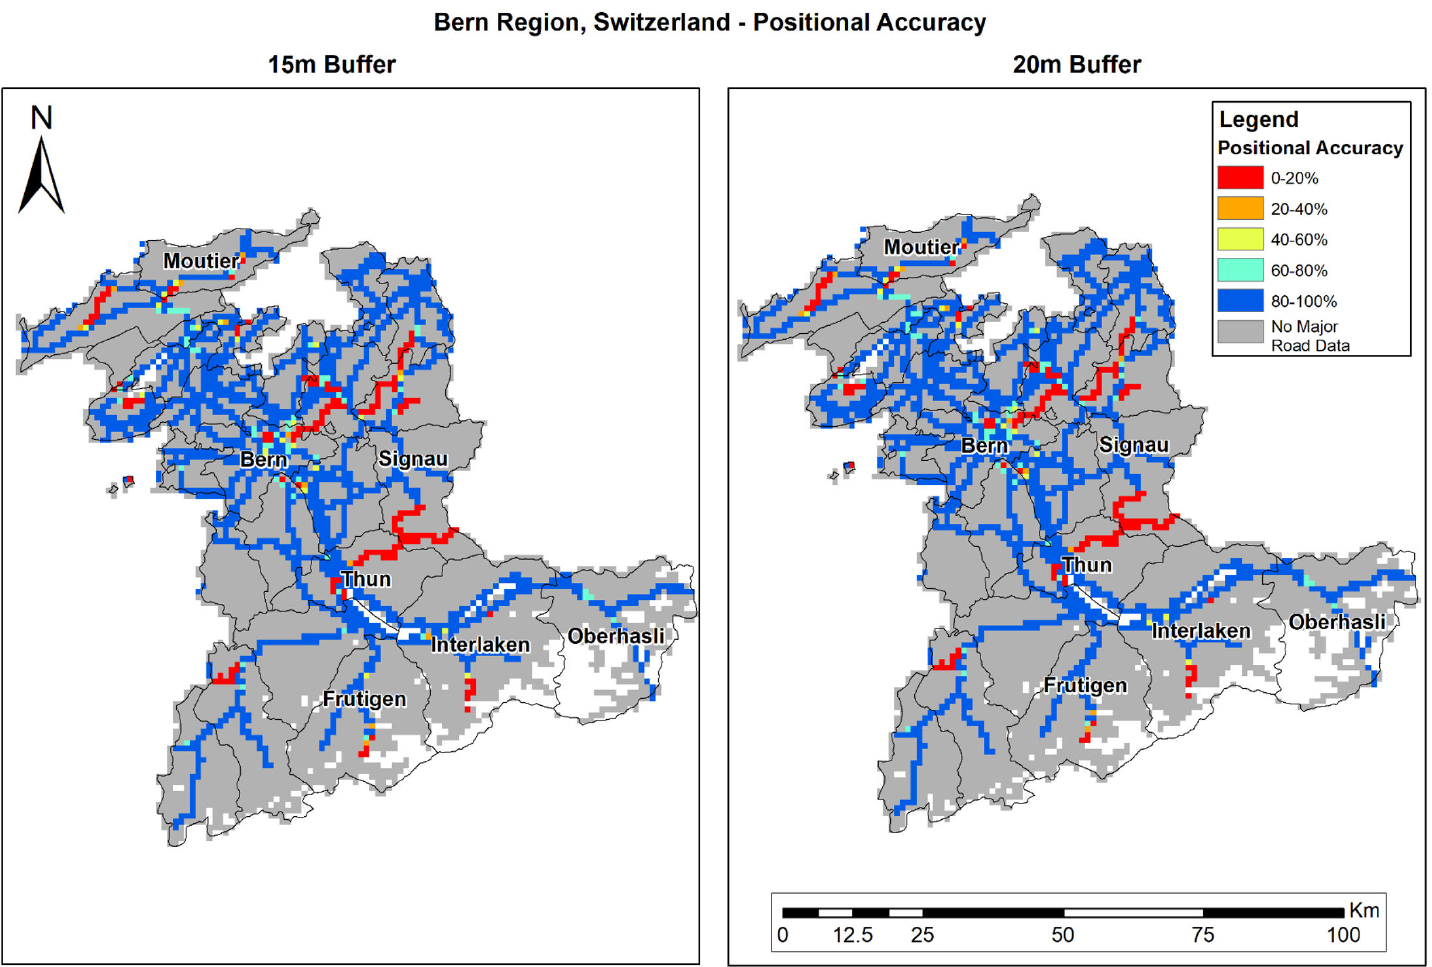
Figure 6. Bern region’s PA (%): 15 m ( left ) and 20 m ( right )